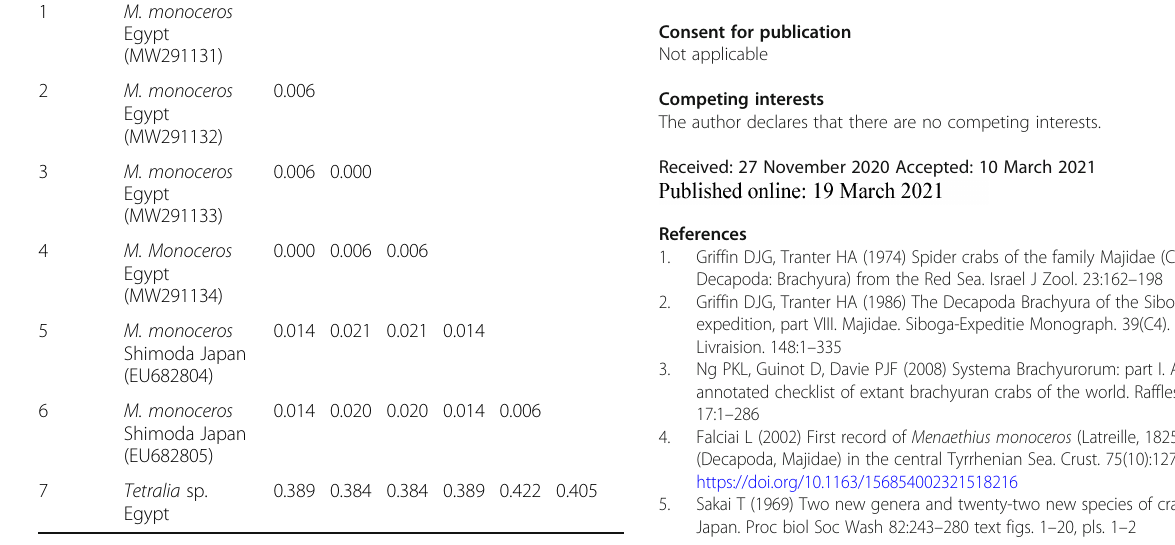
important tool combined with morphology in taxo- nomic studies. Most small-sized crab species inhabiting the Red Sea and associated with seaweeds are difficult to identify morphologically, and thus, the present study used two DNA markers to confirm the identity of two morpho- types of the spider crab Menaethius monoceros . DNA barcoding and phylogeny revealed that there was a vari- ation within the same species. Also, the present study provides baseline DNA data for one species inhabiting the Red Sea, which has recently been reported as mi- grated to the Mediterranean Sea. Our data will be im- portant in further future investigations.